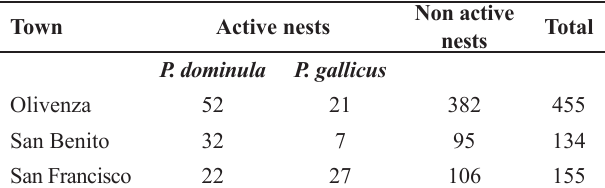
Table 1 . Number of nests in each of the sampled localities.